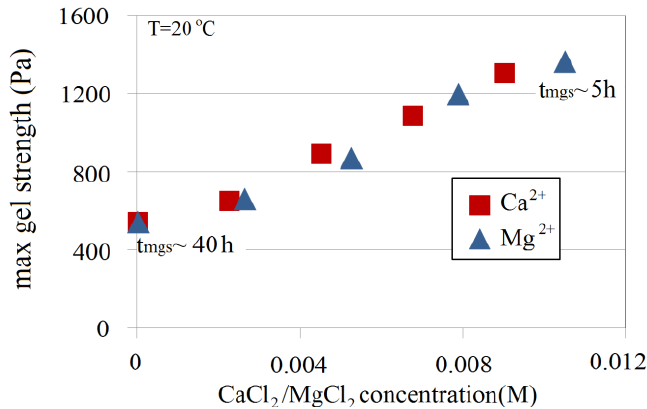
Figure 21. Maximum gel strength as a function of Ca 2+ and Mg 2+ molar concentrations for 4.5 wt% Na-silicate with a pH of i